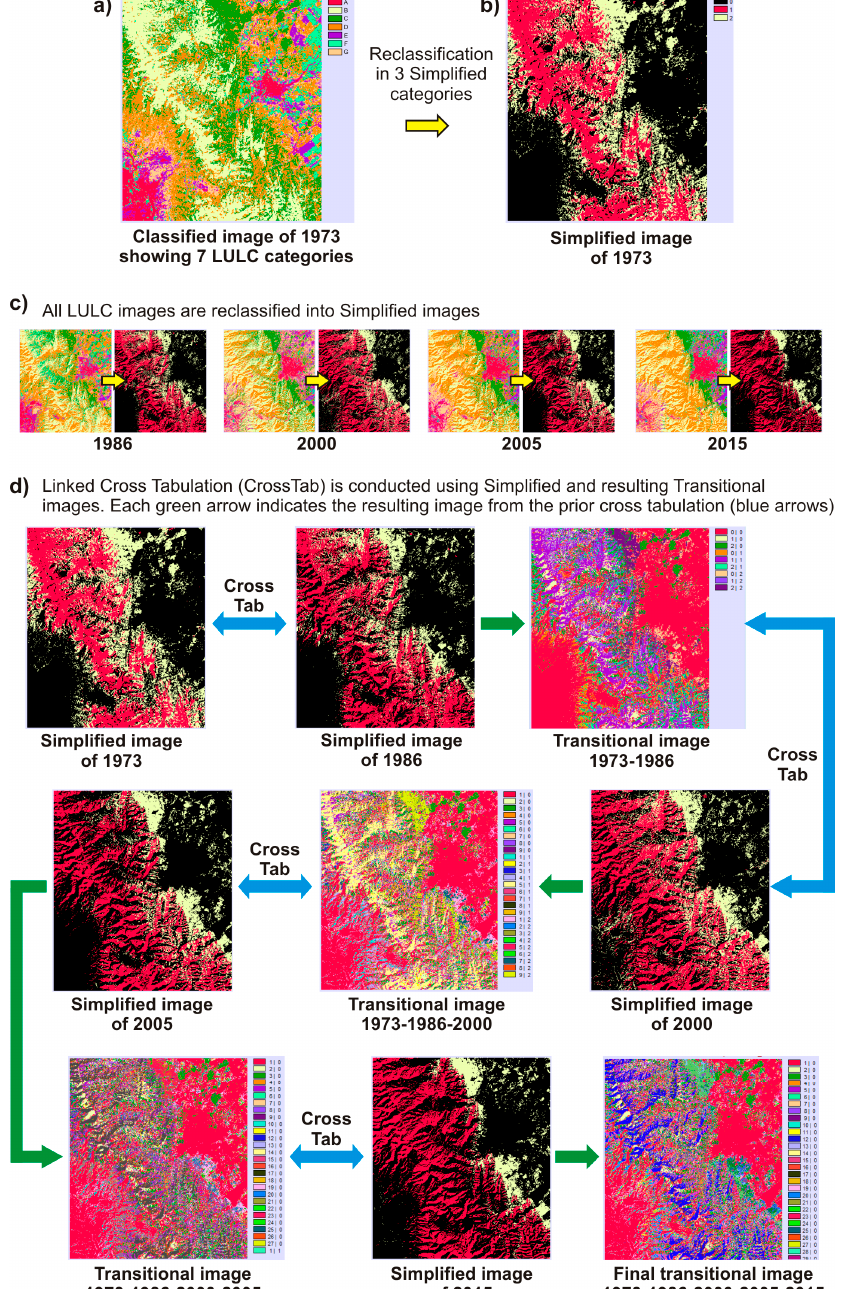
Figure 2. Summarized process for delimiting successional categories. ( a ) The first LULC image classified by MAXLIKE ( b ) is reclassified into three simplified categories: 0 (Disturbance Simplified Category), 1 (Temperate forests) and 2 (Tropical vegetation). ( c ) The other LULC images are reclassified in the same way. ( d ) Cross tabulation is conducted, comparing the Simplified Image of 1973 vs. that of 1986, resulting in a Transitional Image of changes for 1973–1986 with 9 categories. This is compared vs. the next Simplified Image (2000), resulting in a new Transitional Image with 27 categories. The process continues until a final Transitional Image is obtained, with 243 categories of transition from 1973–2015. See text for details.